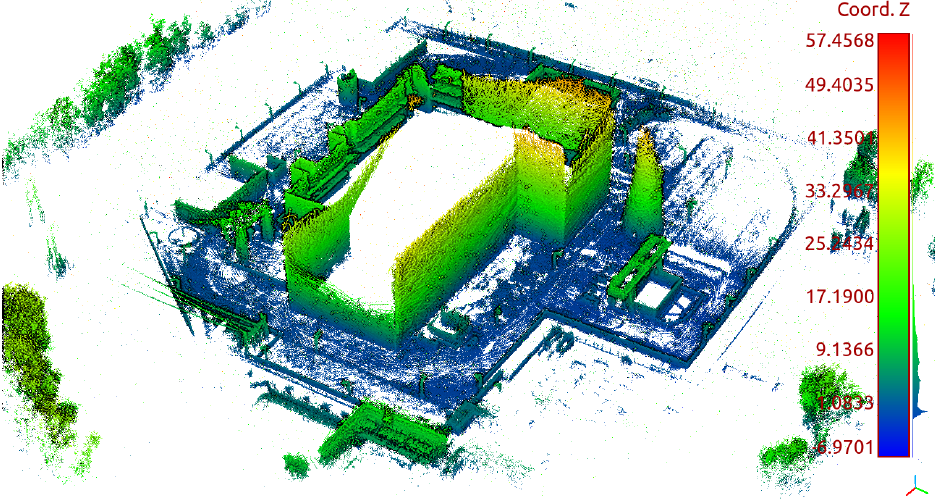
Figure 14. Side view of map of the Zwentendorf NPP obtained with Livox Mid–40 with rotated